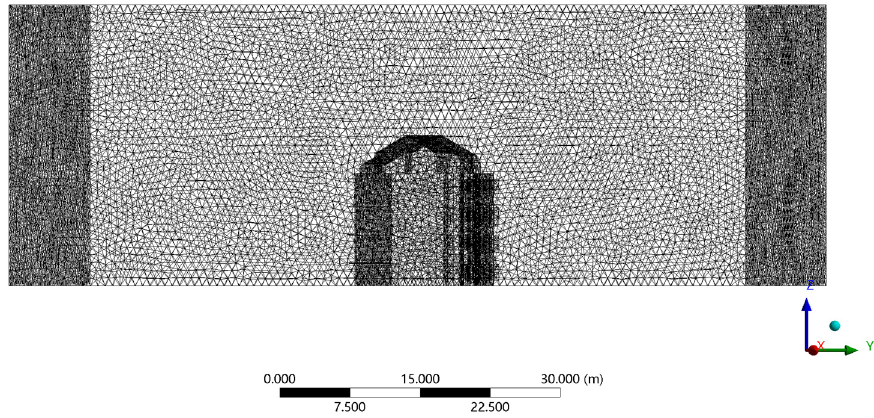
Figure 4. Computational domain meshing.